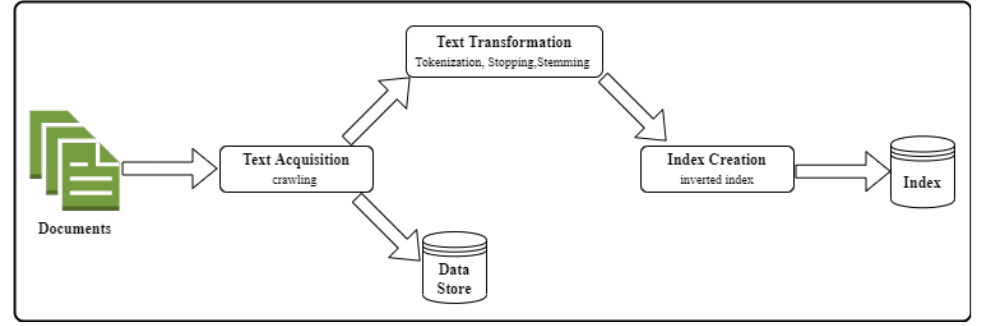
Figure 2. IR Offline process